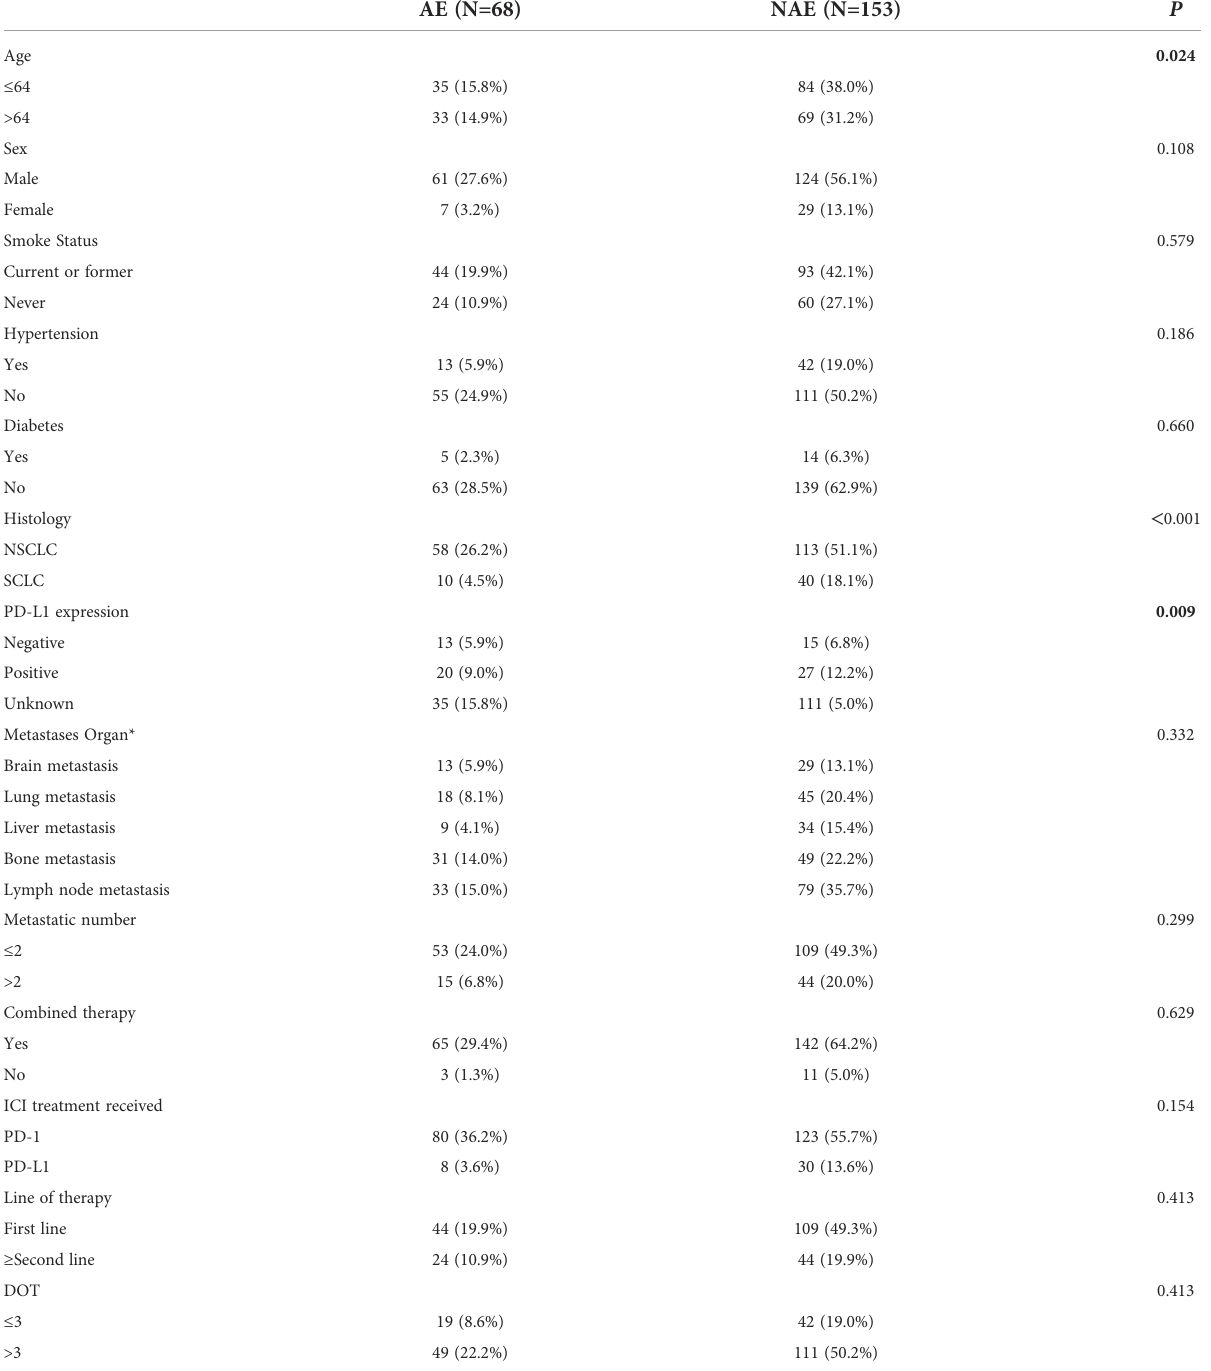
TABLE 1 Relationship of clinicopathological between AE and